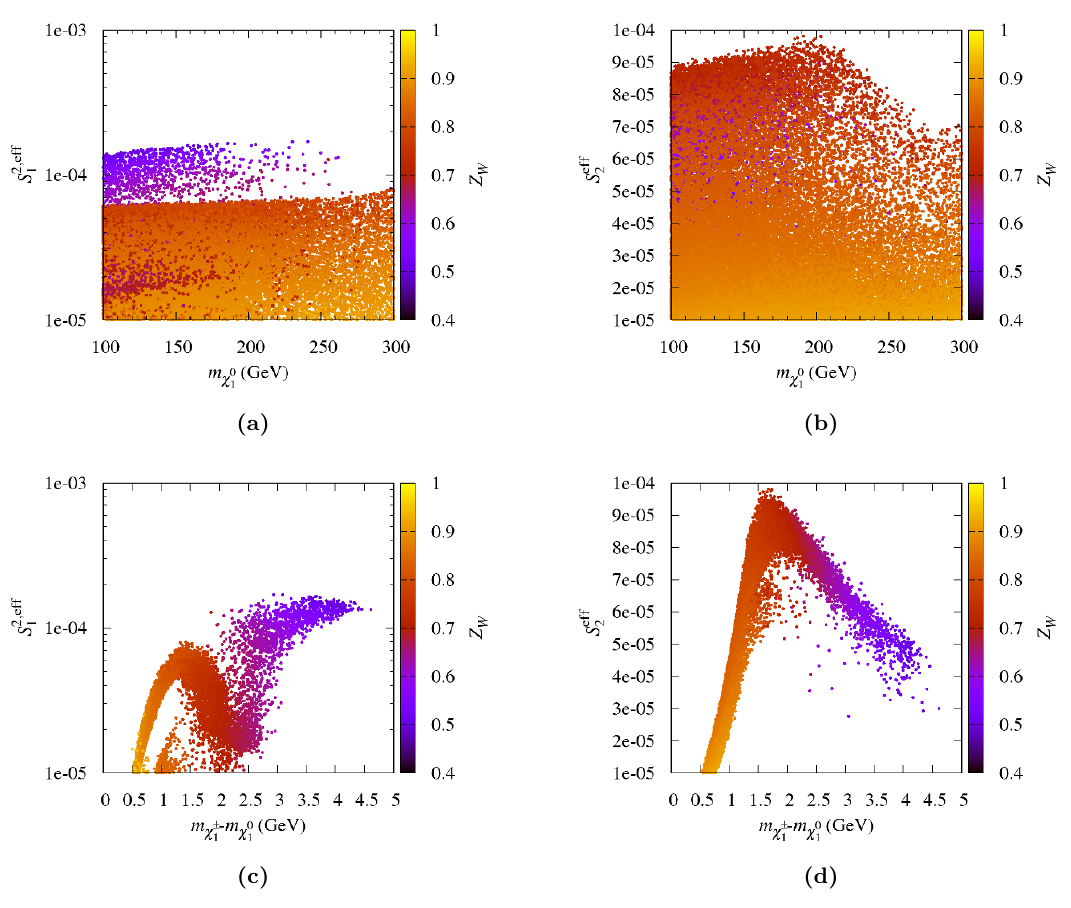
Figure 3. (a) S 2 ; e(cid:11) quantities are plotted, respectively, as functions of the all the panels correspond to the wino component in